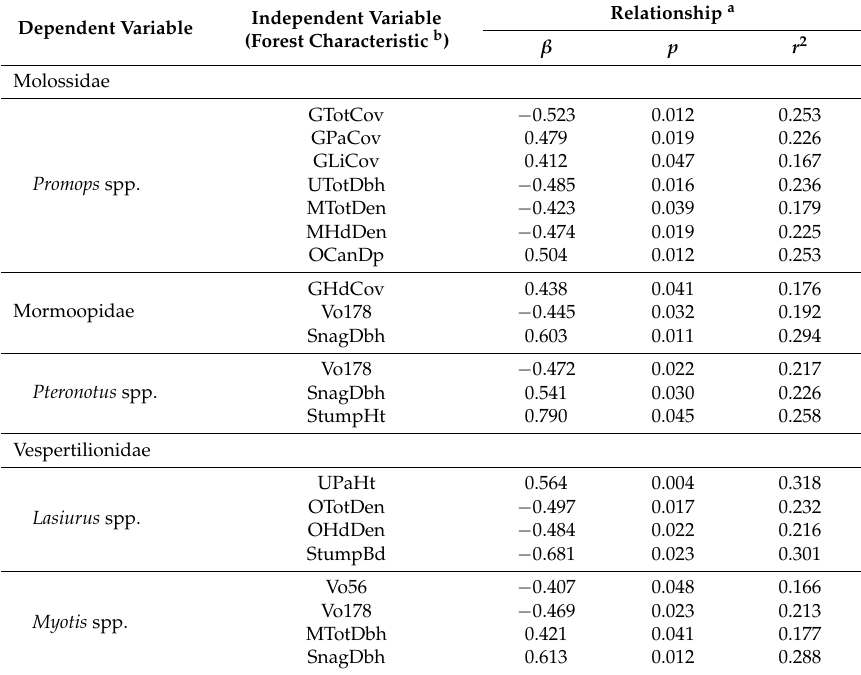
Table 4. Bat activity relationships with forest structure and composition for common families and genera (>100 passes) in the Chiquibul Forest Reserve (CFR), Belize, Central America, in summer